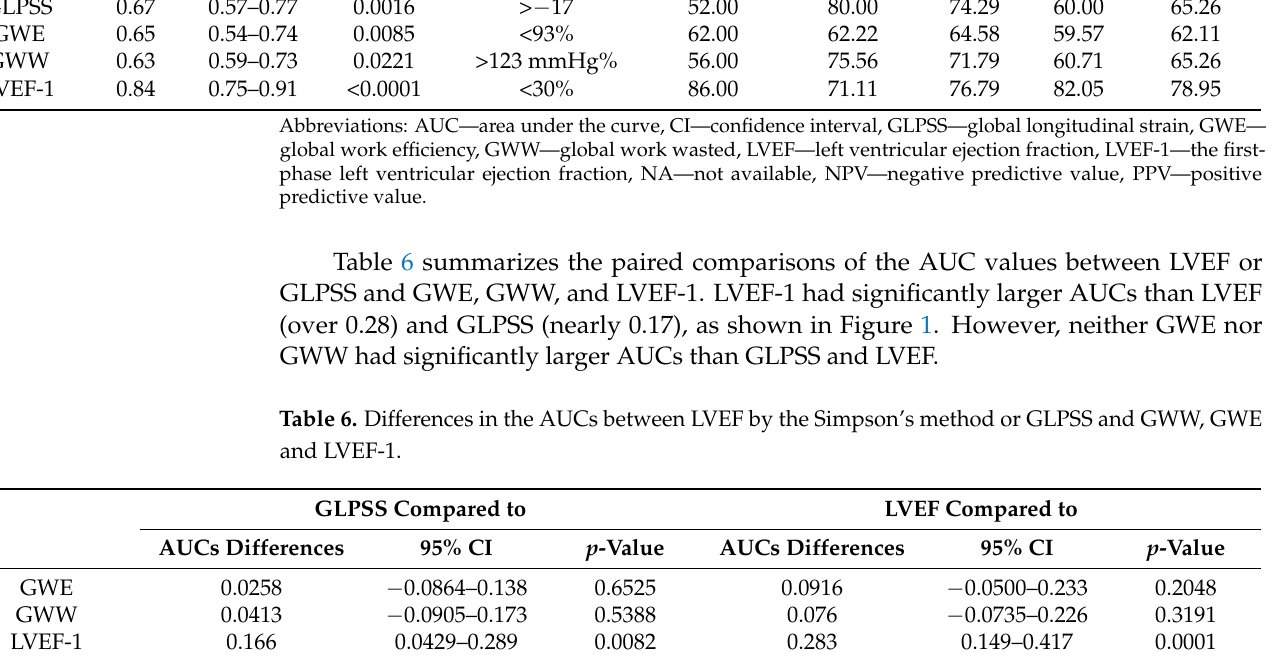
Table 5. AUC for standard (LVEF and GLPSS) and newer (GWW, GWE, and LVEF-1) LV systolic function indices to differentiate CAD patients from healthy controls.